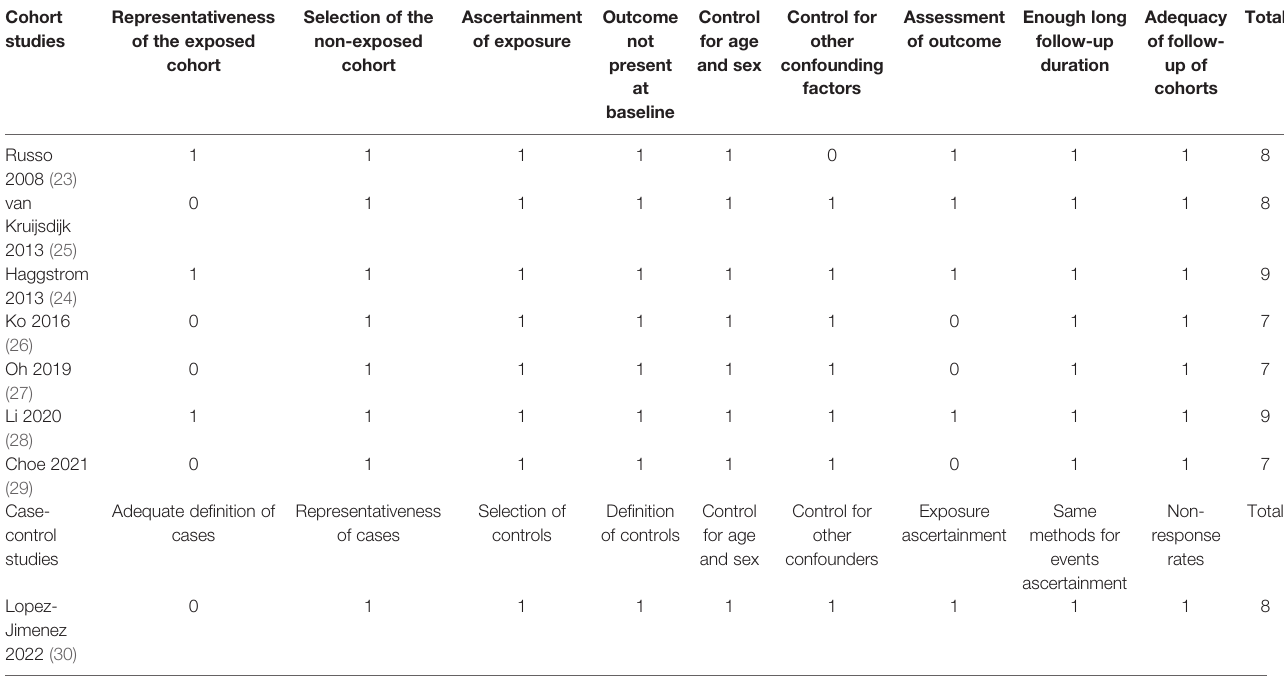
TABLE 2 | Details of study quality evaluation via the Newcastle-Ottawa Scale. Cohort Representativeness studies of the